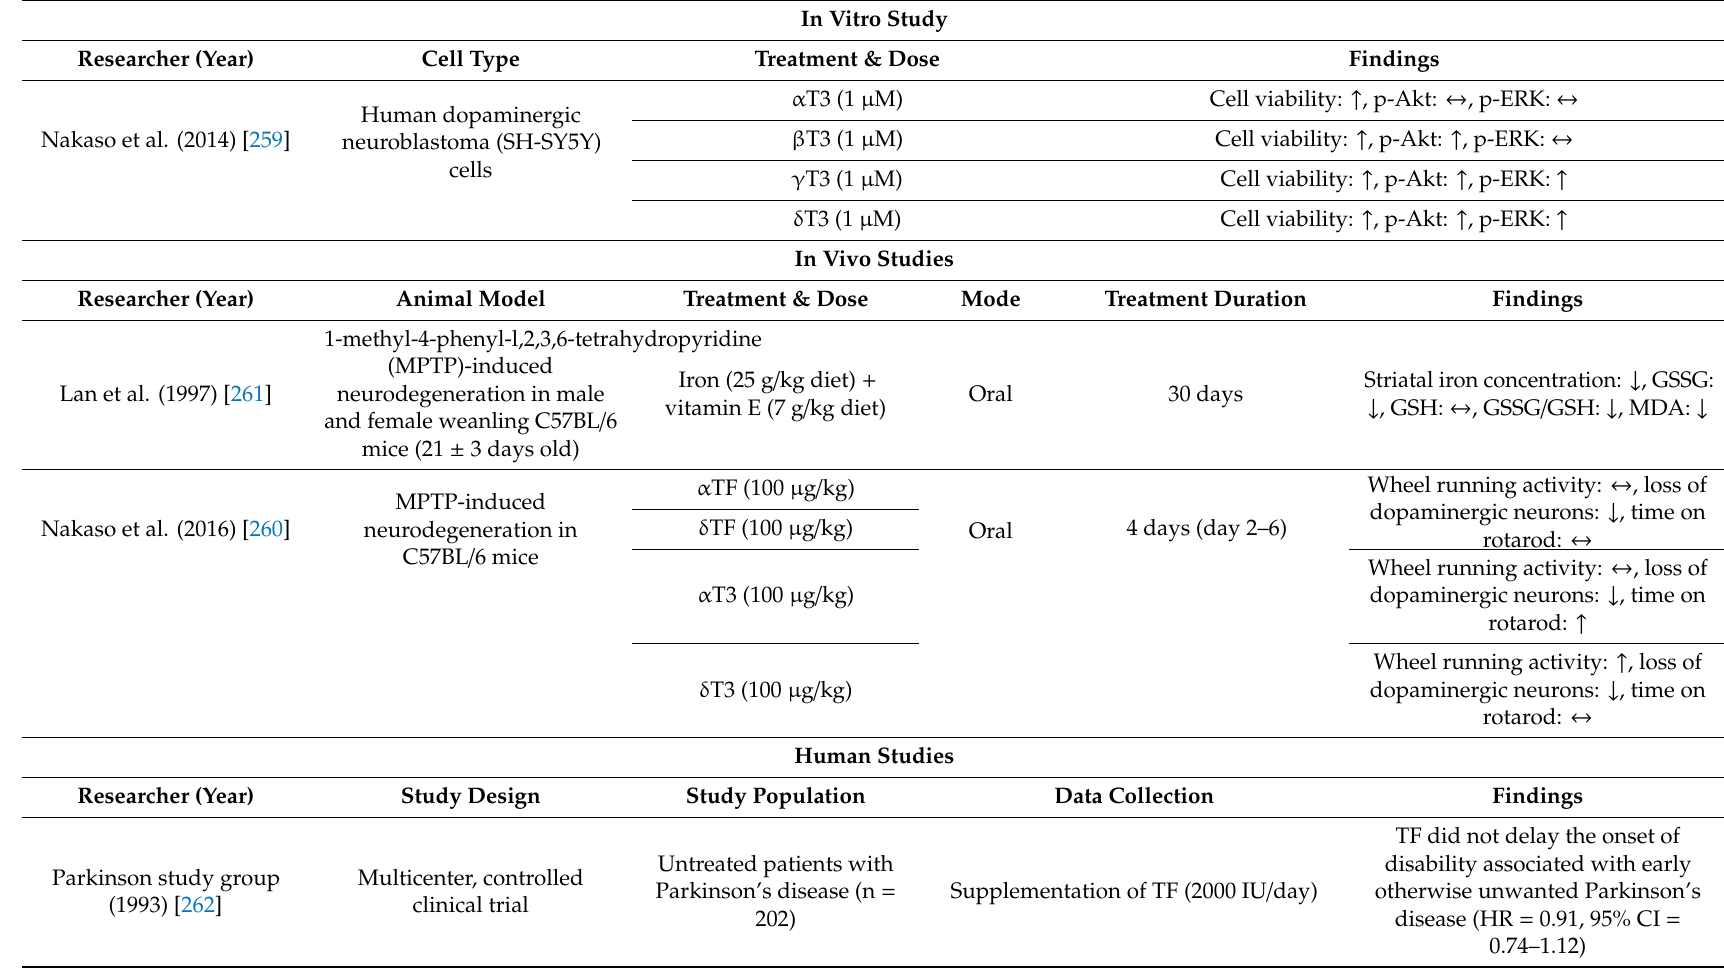
Table 12. E ff ect of T3 on Parkinson’s